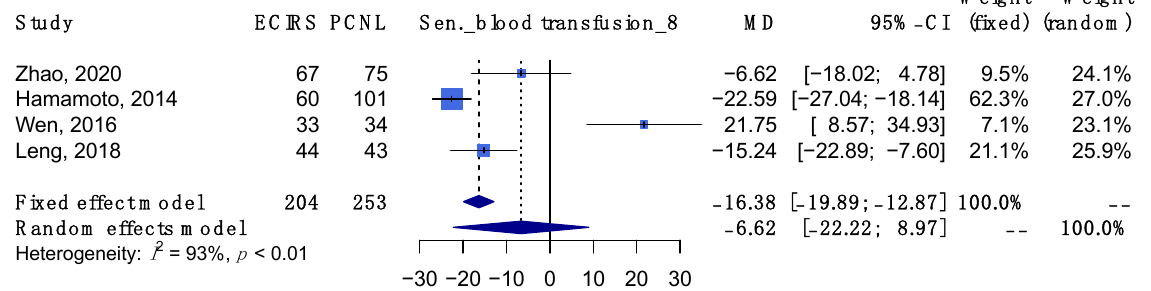
Figure A33. Sensitivity analysis of outcome regarding hemoglobin drop. ([18,19,22])